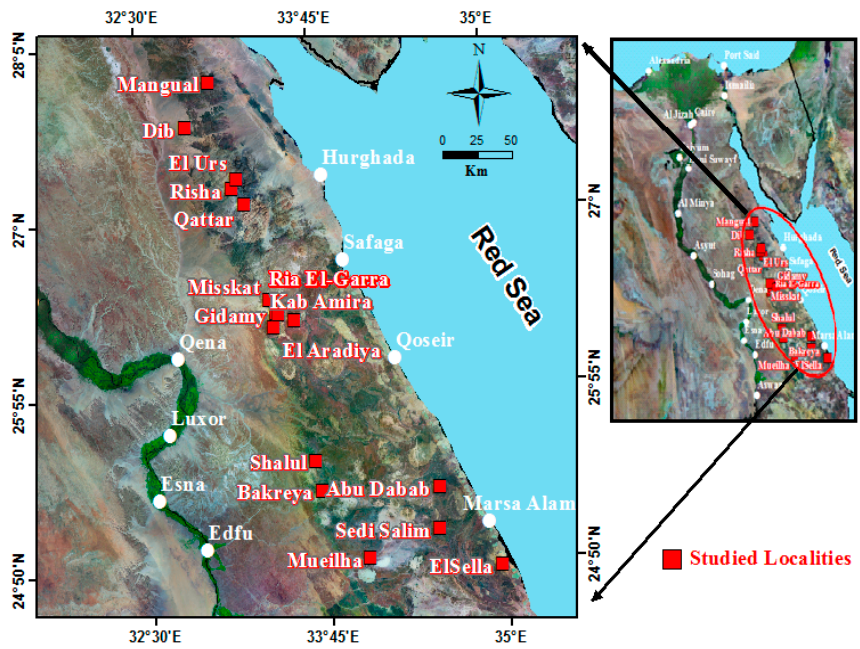
Figure 1. Map of total studied locations.